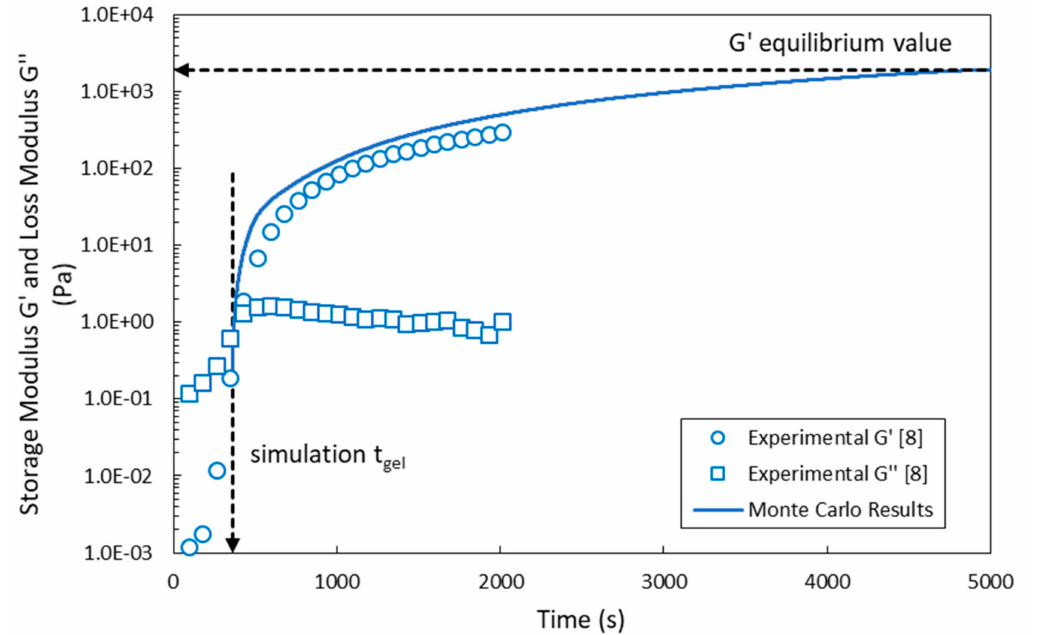
Figure 12. Comparison of MC results (blue line) with the reported experimental measurements (blue dots) on storage modulus during gelation for the HA-Tyr crosslinkable system [8]. The MC simulation results were obtained with an initial polymer chains population of ~10 6 . The vertical dash line marks the gelation onset time as predicted by the 4D MC algorithm. The horizontal dash line denotes the equilibrium value of G (cid:48) as reported by Lee et al. [8]. The experimental measurements (blue squares) of the loss modulus ( G” ) are also